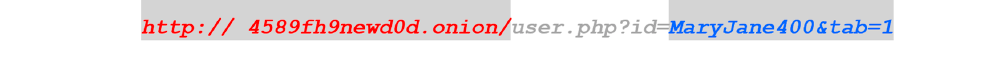
Figure A7. URL Construction for Each Account Listing.